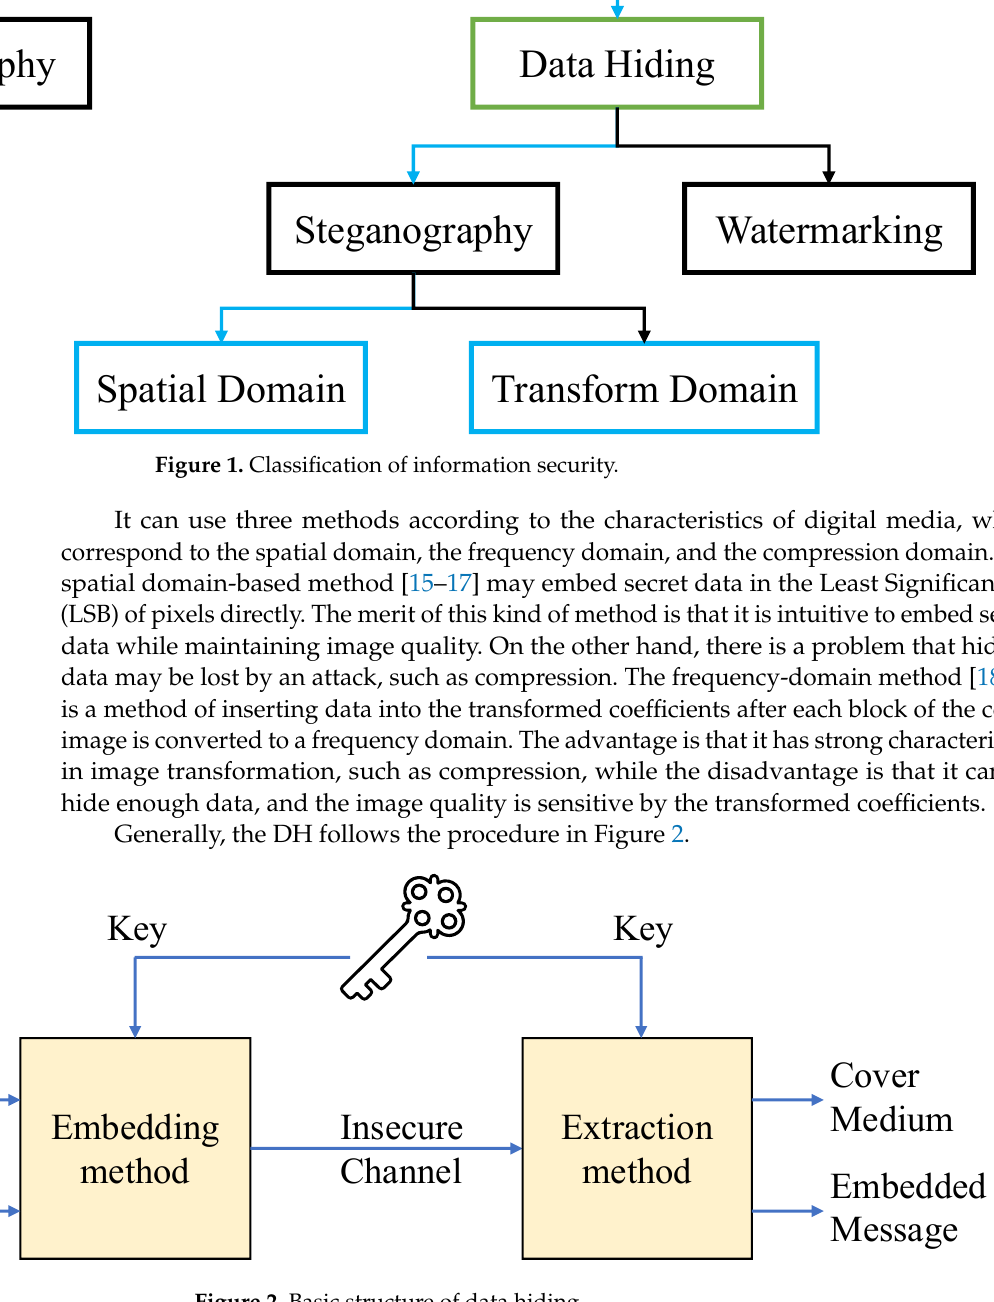
Figure 2. Basic structure of data